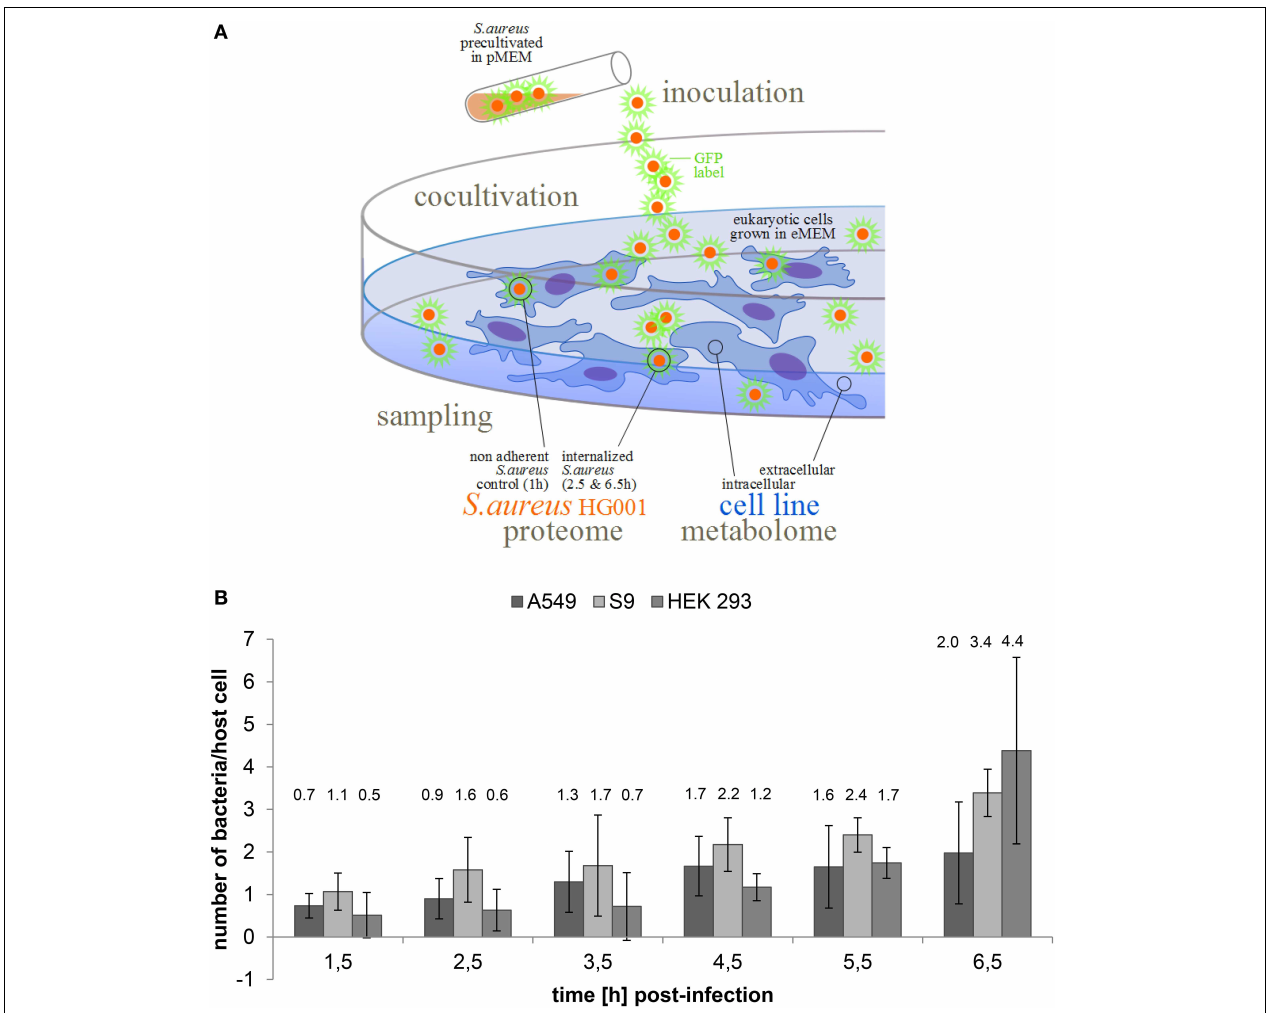
FIGURE 1 | Internalization of S. aureus HG001 by human cell lines. (A) Experimental course of action. GFP expressing bacteria were cultivated in pMEM until OD 600 0.4 (exponential growth). Human cell lines (S9, A549, and HEK 293) were cultivated in eMEM and infected with S. aureus HG001 pMV158GFP cells. The proteome of the non-adherent and the internalized bacteria was investigated after cell sorting via flow cytometry.